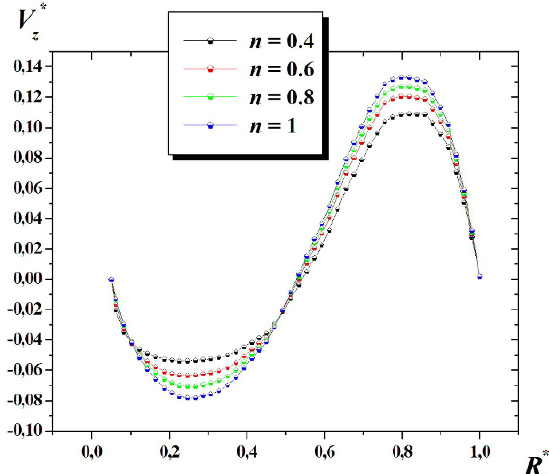
Figure 9. Radial velocity for double helical ribbon impeller, at Re 60 , R ∗ = 0 . 74 , θ = 0 0